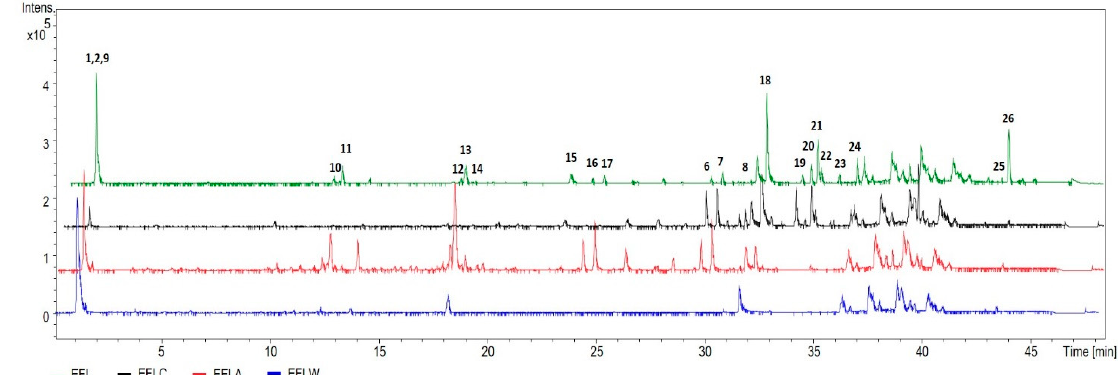
Figure 3. Base peak chromatogram (BPC) obtained by HPLC-DAD-MS of EEL extract and the fractions EELC (chloroform fraction), EELA (ethyl acetate fraction), and EELW (hydromethanolic fraction). The identification of chromatographic peaks is described in Table 2 and all the chromatograms are in the same intensity range.